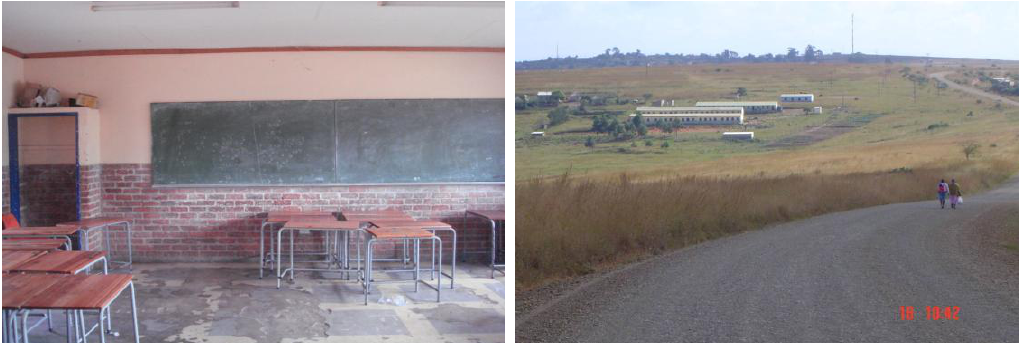
Figure 1 . Disadvantaged schools in rural